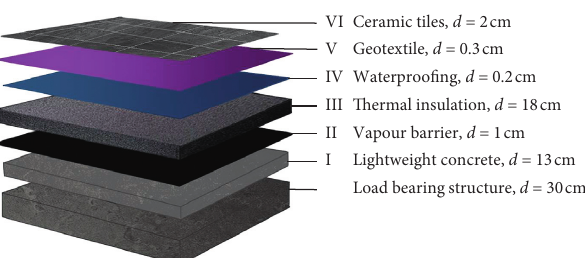
Figure 1: Conventional flat roof layers (the figure is created by authors upon data collected from cost estimate for the building under construction).